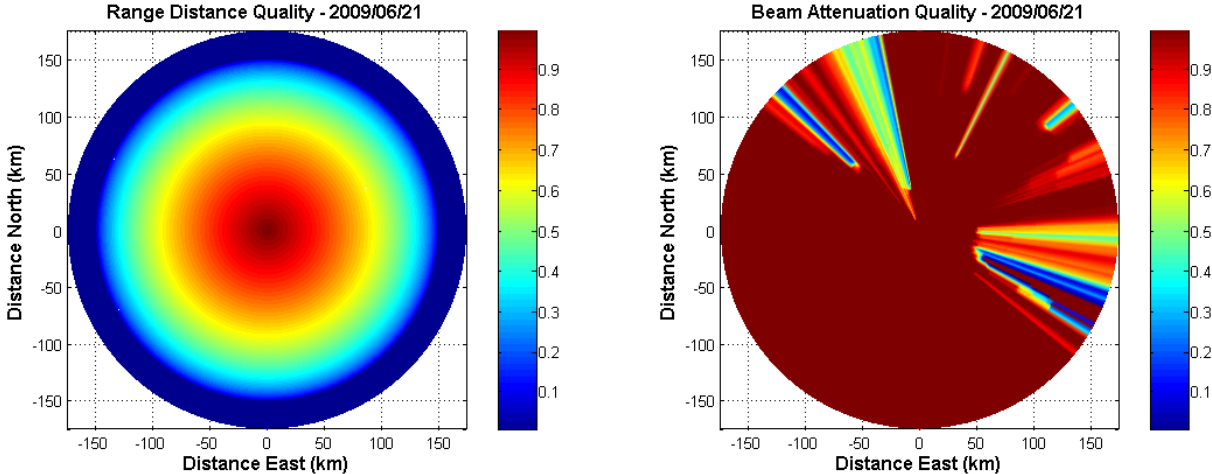
Fig. 6. Range distance (left) and attenuation (right) quality map associated with radar “Il Monte”, on 21 June 2009, at 14:00UTC, elevation Fig. 6: Range distance (left) and attenuation (right) quality map associated to radar “Il Monte”, on 1373 0.4. June 21, 2009, at 14.00 UTC, elevation 0.4. 1374